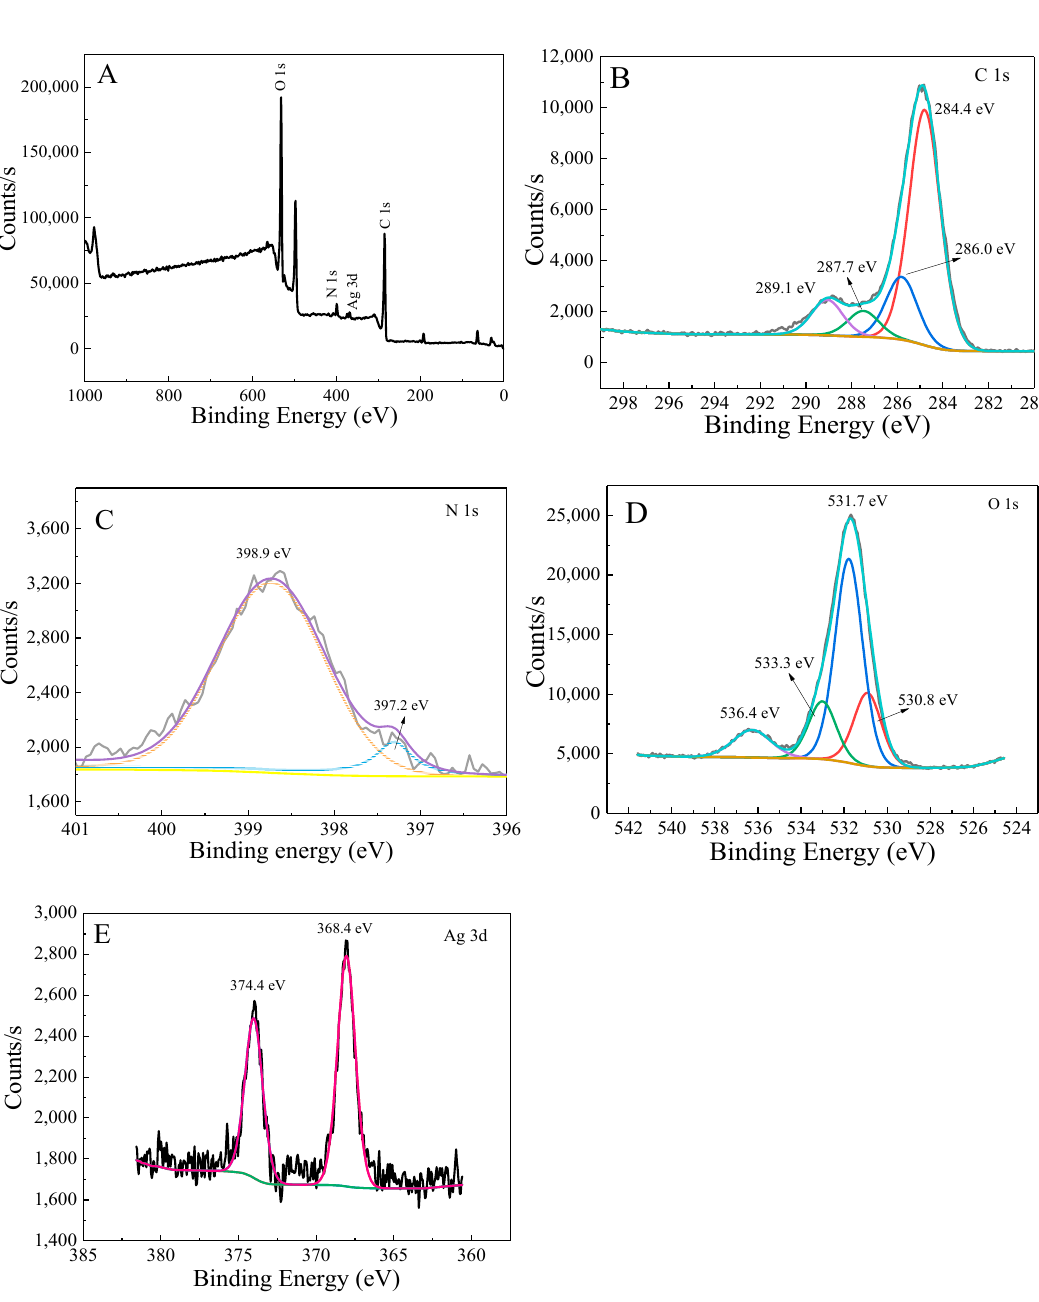
Figure 8 . XPS spectra of AgCOF. ( A ) Survey, ( B ) C 1s, ( C ) N 1s, ( D ) O 1s, and ( E ) Ag 3d.